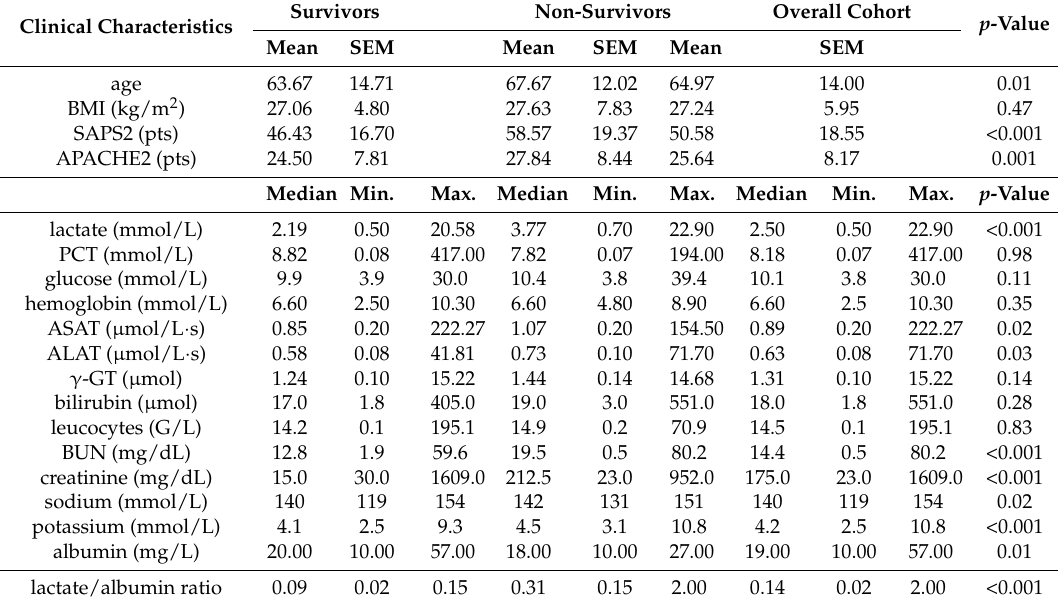
Table 1. Laboratory and clinical baseline characteristics; survivors vs. non-survivors.